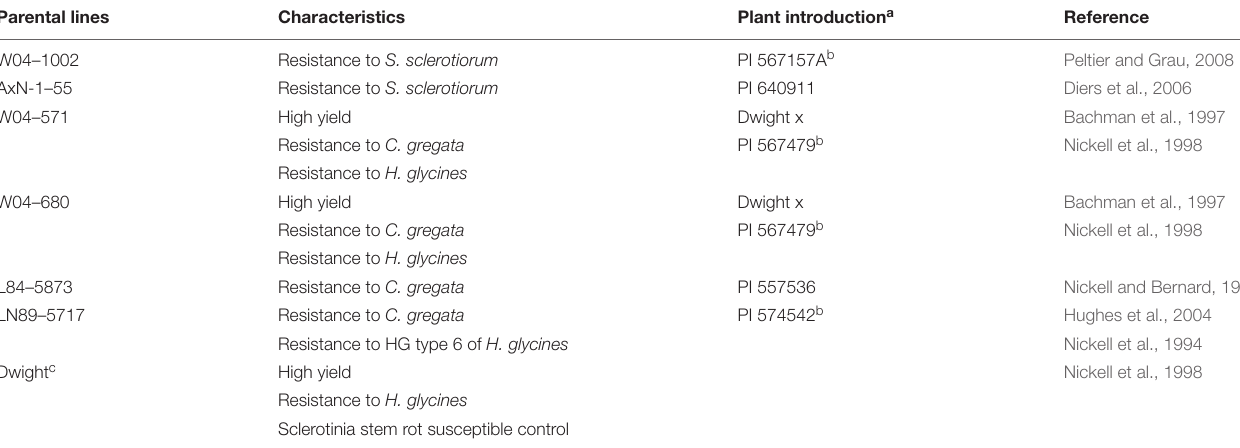
TABLE 1 | Parental lines of initial crosses, desirable characteristics, plant introduction number, and line evaluation references. Parental lines